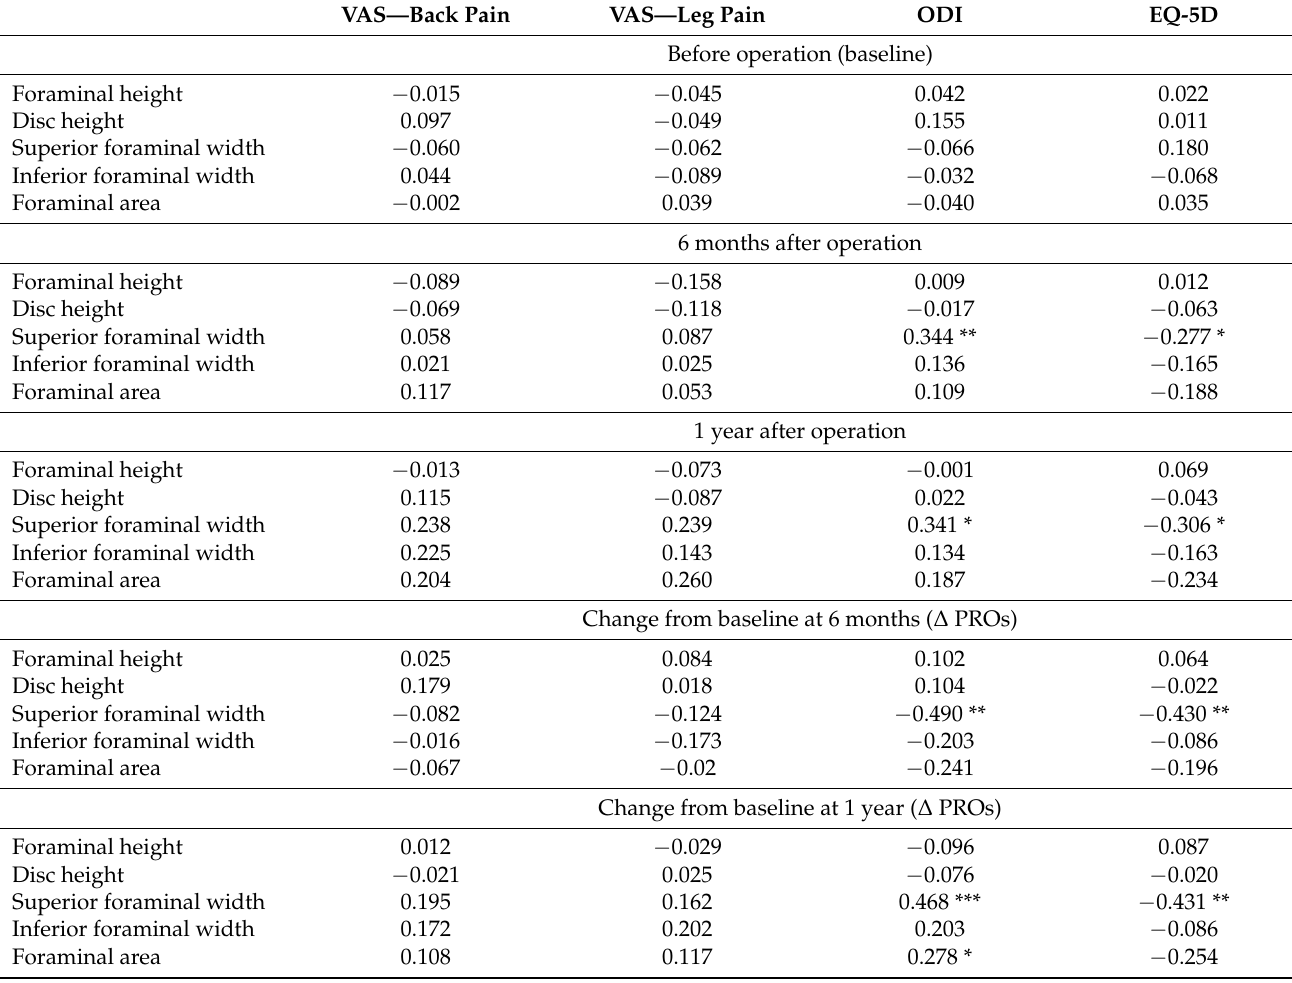
Table 3. Correlations between parameters from MRI and patient-reported outcomes (PROs).